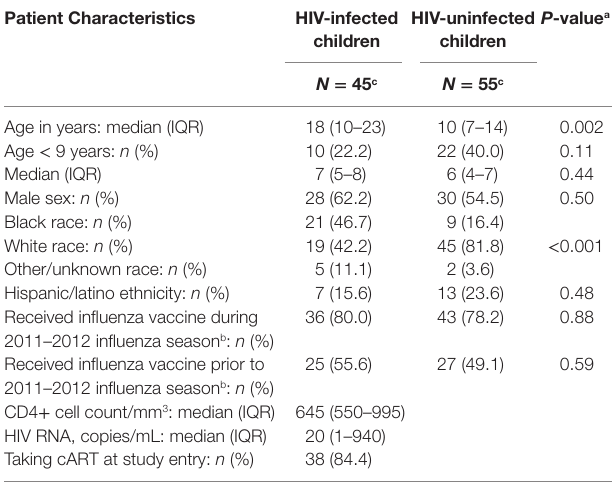
TaBle 1 | Demographics and hiV disease characteristics of the study